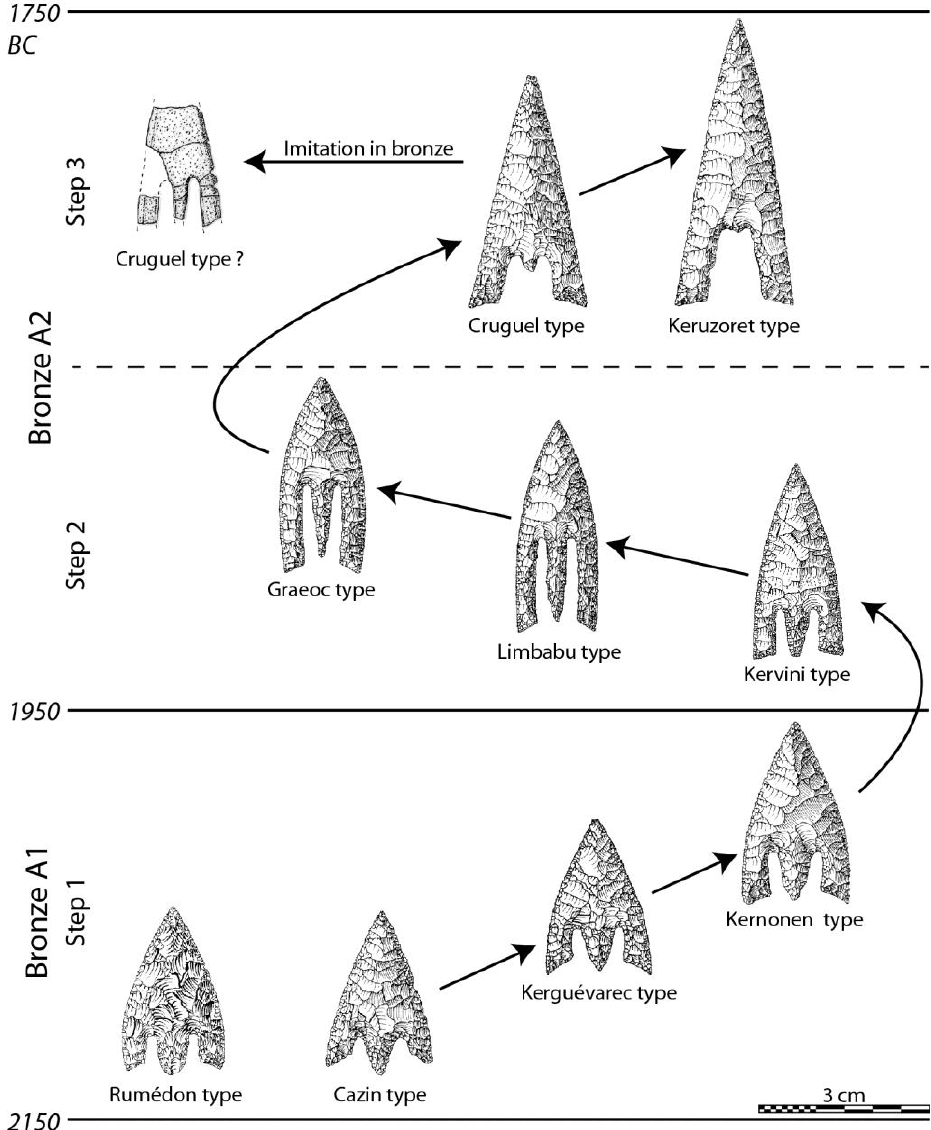
Figure 5. Evolution of the Armorican arrowheads (drawings C.